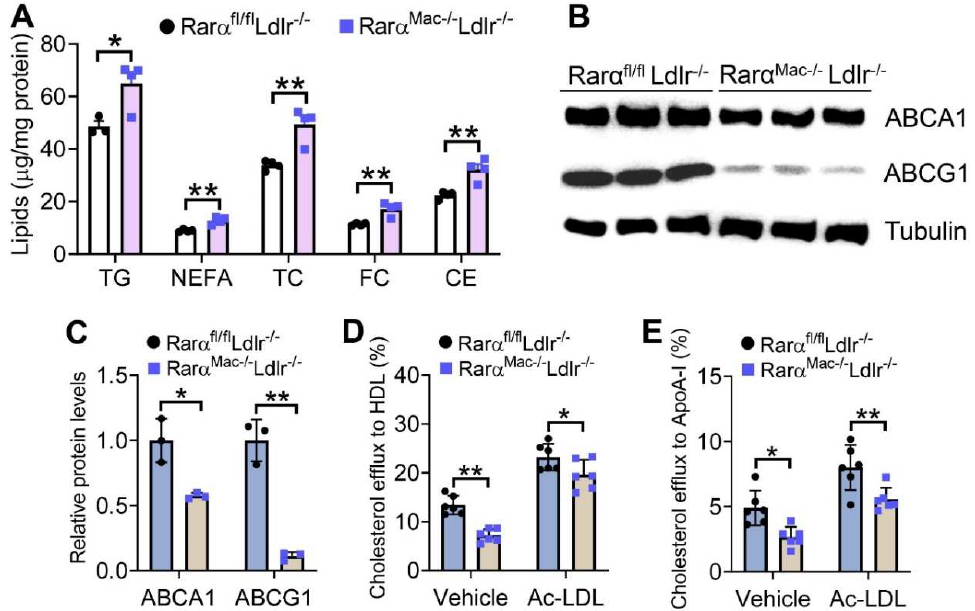
Figure 4. Loss of RAR α in Western diet-fed Ldlr -/- mice promotes foam cell formation by suppressing cholesterol efflux to HDL and ApoA-I. Rar α fl/fl Ldlr -/- and Rar α Mac-/- Ldlr -/- mice were fed a Western diet for 16 weeks. The levels of intracellular lipids ( A ) and proteins ( B , C ) in peritoneal macrophages were determined ( n = 3–4). Macrophage cholesterol efflux to HDL ( D ) or ApoA-I ( E ) was determined ( n = 6). In ( C – E ), ordinary two-way ANOVA with Tukey’s multiple comparisons test was used for statistical analysis. All the data are expressed as mean ± SEM. * p < 0.05, ** p < 0.01. 3.5. Macrophage RARα Deficiency in Ldlr -/- Mice Promotes the Development of Atherosclerosis In addition to inhibiting macrophage cholesterol efflux, RARα deficiency in Ldlr -/- mice also induced Tnfα and Il1β expression in macrophages (Figure 5A). Therefore, Rarα Mac-/- Ldlr -/- mice had a 50% increase in en face aortic lesions (Figure 5B,C), and a 34% increase in aortic root lesions (Figure 5D,E). The changes in atherosclerotic lesions were S2). Thus, macrophage RAR α deficiency promotes the development of atherosclerosis,